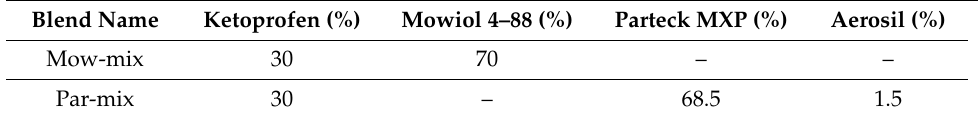
Table 1. Physical mixture